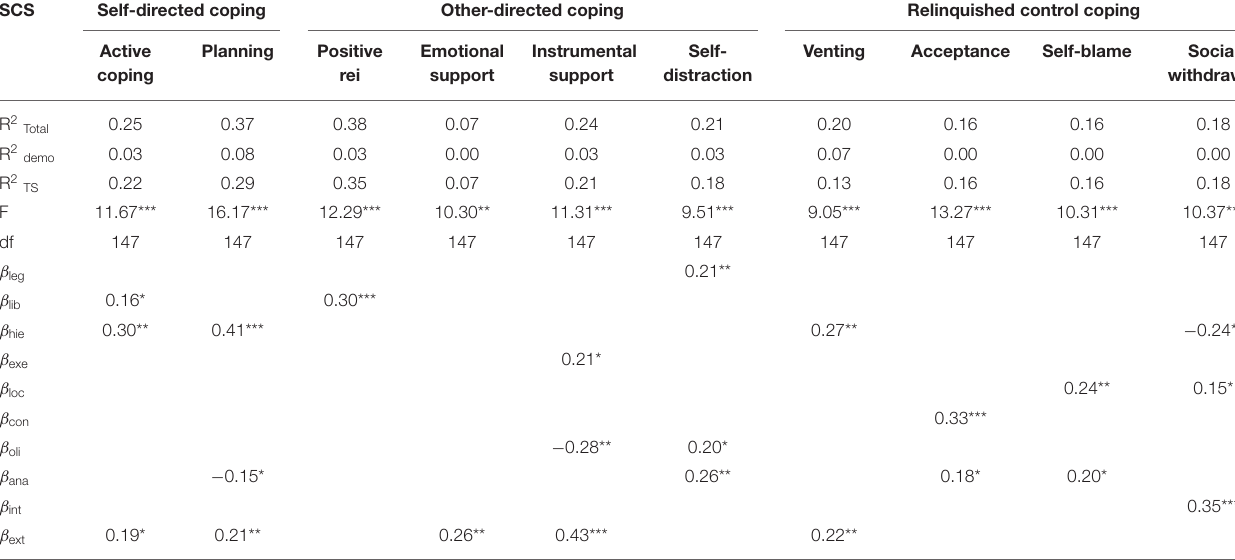
TABLE 3 | Predicting coping strategies from thinking styles. SCS Self-directed coping Other-directed coping Relinquished control coping Active